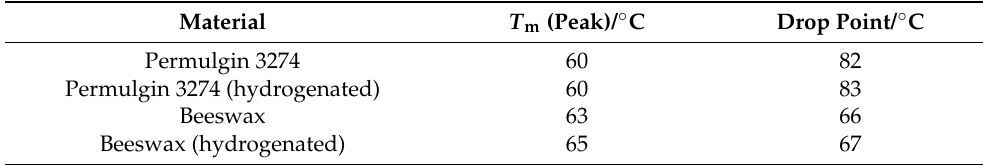
Figure 4. Comparison of DSC heating curves of ( a ) Permulgin 3274, ( b ) hydrogenated Permulgin 3274 and ( c ) recent beeswax. ( d ): Detail of the cooling curve of Permulgin 3274. Table 1. DSC melting temperature and drop point of Permulgin 3274, beeswax and their hydro- genated